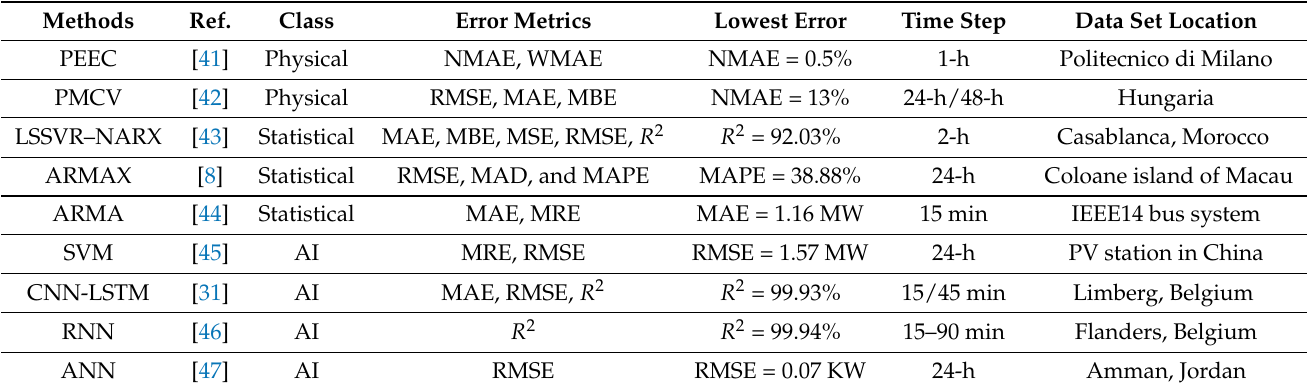
Table 1. A summary of the literature